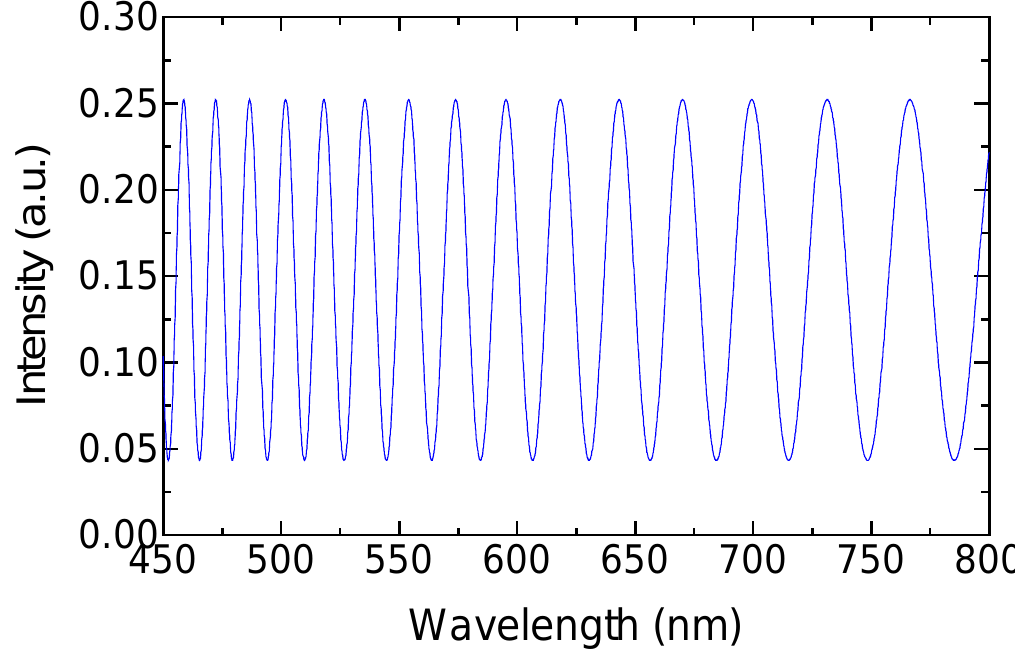
Figure 4. Output spectrum of the approximated model.